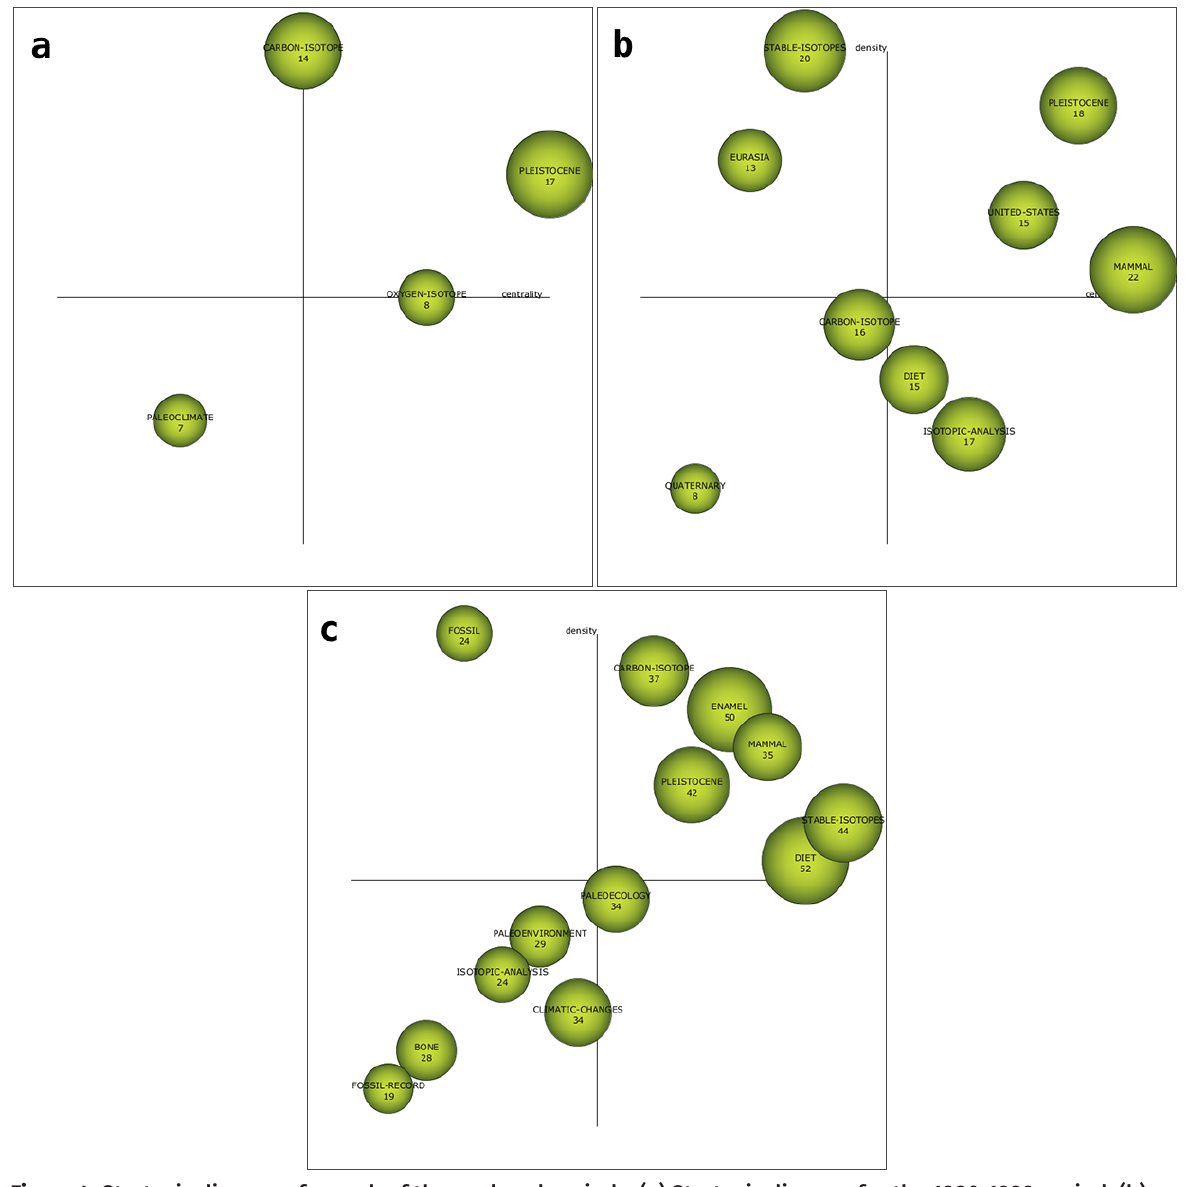
Figure 4. Strategic diagrams for each of the analyzed periods. (a) Strategic diagram for the 1980-1999 period, (b) Strategic diagram for the 2000-2009 decade, (c) Strategic diagram for the 2010-2019 decade. Source: